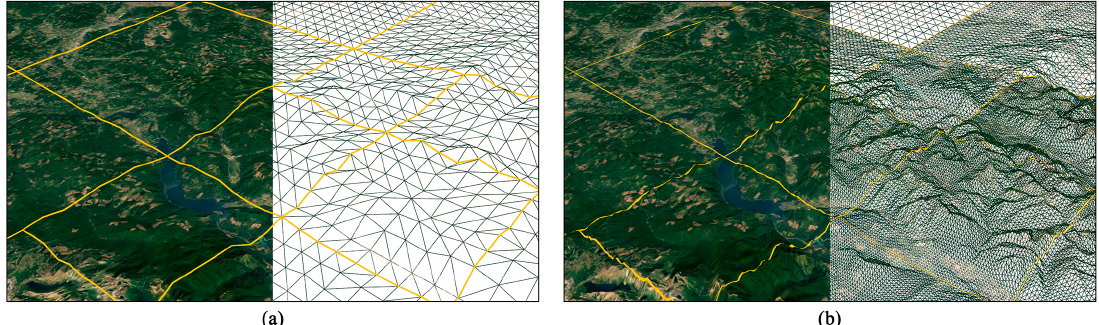
Figure 18. Comparison of meshes of the two methods in Area I (height map size: 1025 × 1025): ( a ) Method I. ( b ) Our method.